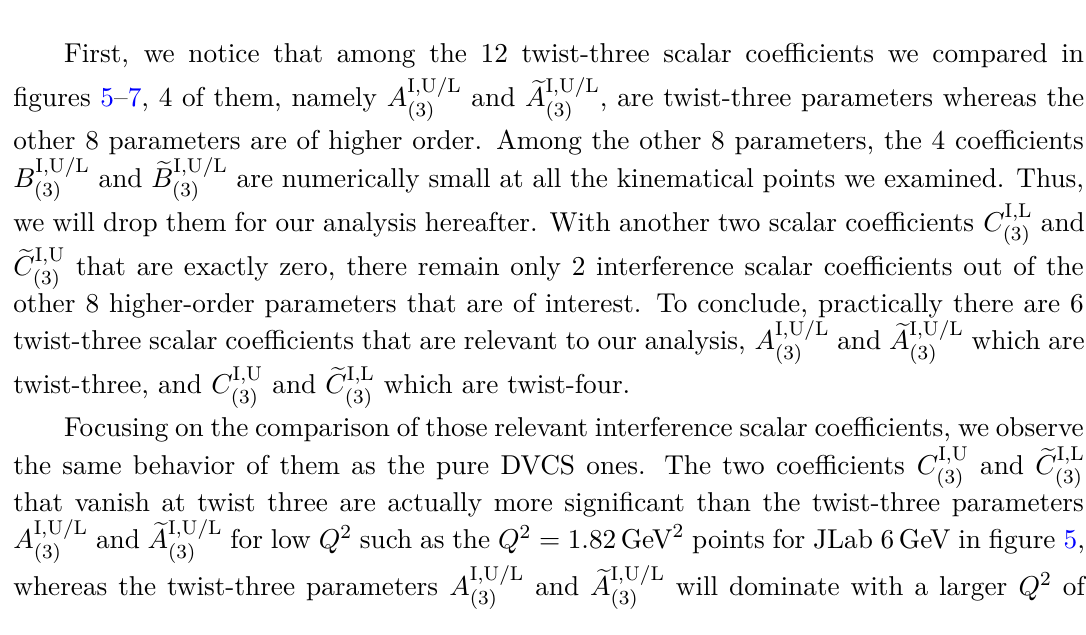
Figure 6 . Another comparison of the interference coefficients A I , U / L for JLab 12 GeV. Again, the four plots compare different sets of scalar coefficients that enter different polarization configurations, and we put in the twist-two scalar coefficients A I , U / L background for comparison. The twist-two coefficients (black lines) dominates the higher-twist